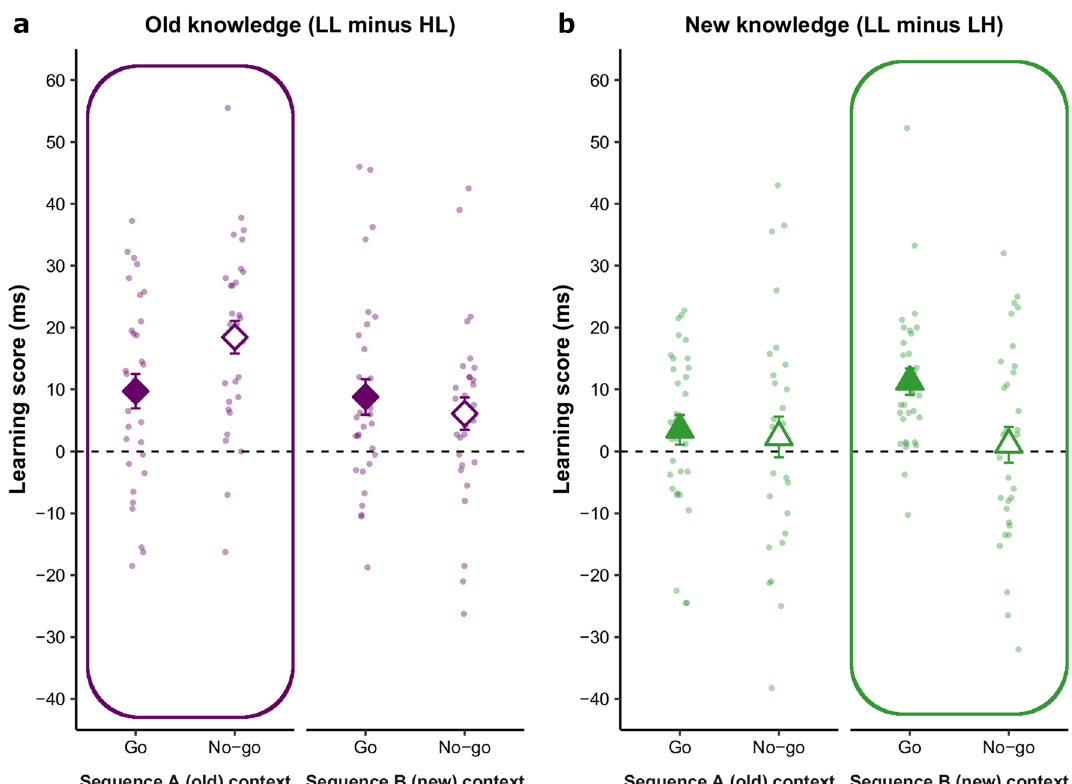
Figure 4. The effect of inhibitory control on old and new knowledge as revealed by performance in the Testing phase. The circled panels indicate the testing context (task version with Sequence A or B) in which higher learning scores were expected. For example, for the new knowledge (‘LL minus LH’ learning score), higher learning scores were expected in the new context (when stimulus presentation order followed Sequence B), since trials with high vs. low triplet occurrence probabilities were contrasted here (‘LL minus LH’, underlined letters indicating probabilities of the current comparison; see also Fig. 2). ( a ) Old knowledge. When tested on Sequence A (the original, old context), participants showed significant above-zero performance on Go and No-go trials, with significantly higher learning scores for the latter. This suggests that the old knowledge was present, and inhibiting responses during rewiring strengthened, instead of facilitated, its unlearning. When tested on Sequence B (the new context), participants exhibited similar, significantly above-zero learning scores on Go and No-go trials, suggesting that old knowledge was expressed even when it was not relevant, irrespective of whether responses were inhibited during rewiring. ( b ) New knowledge. When tested on Sequence B (the relevant, new context), participants showed significant above-zero learning scores only on Go trials and these learning scores differed significantly from those on No-go trials, indicating that new knowledge could be expressed only if responses were allowed to the relevant stimuli during rewiring. Thus, actively engaging in the new behavior- to-be-learned seemed essential for acquiring (and subsequently accessing) the new knowledge. When tested on Sequence A, participants’ learning scores did not differ significantly from zero either on Go or No-go trials. This was expected since contrasted trials were all low-probability in Sequence A (‘LL minus LH’). Error bars represent